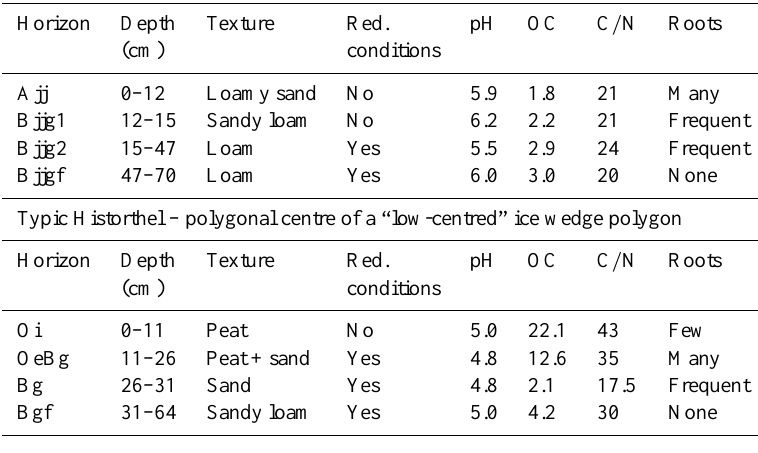
Table 3. Current projects and programmes with the focus on permafrost-affected regions with their carbon pools and carbon dynamics. Acronym Project/programme title Website CAPP Carbon Pools in Permafrost